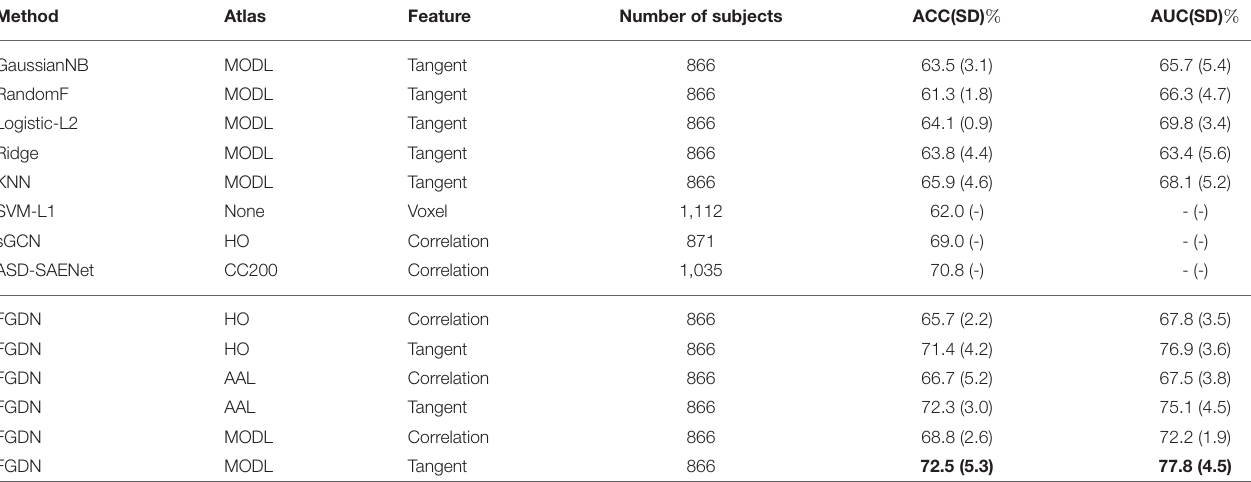
TABLE 1 | Five-fold cross-validation performance.